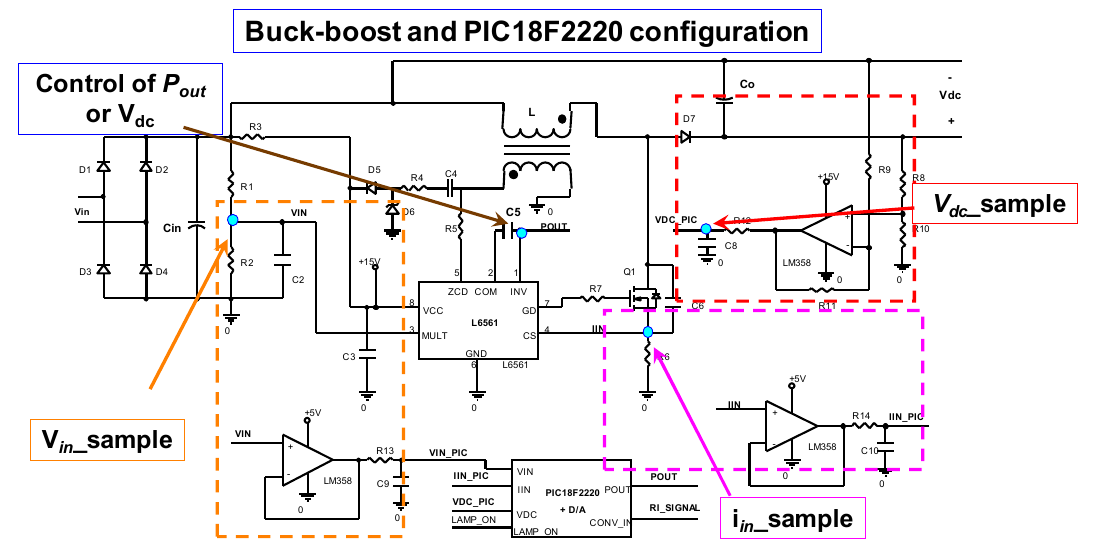
Figure 8. PFC buck-boost controlled by the microcontroller PIC18F2220. The soft start-up ignition sequence is a frequency sweep from low gain values to a frequency with enough voltage gain for ignition, close to resonance. This method produces a gradual growth of voltage and current during the transient, constituting a safe mode of operation; achieving the lighting of the lamp with a lower level of voltage than other methods [12,20]. During the start-up and warm-up time of the lamp V dc and P lamp follow the curves shown in Figure 9. The PFC stage begins operating as a limited voltage source at V dc = 400 V and remains in this mode until P lamp = 150 W. When the power reaches this value, the ballast changes to work in power source mode. In steady state, V dc is adjusted to keep P lamp constant and the microcontroller modifies the value of P ref for dimming.